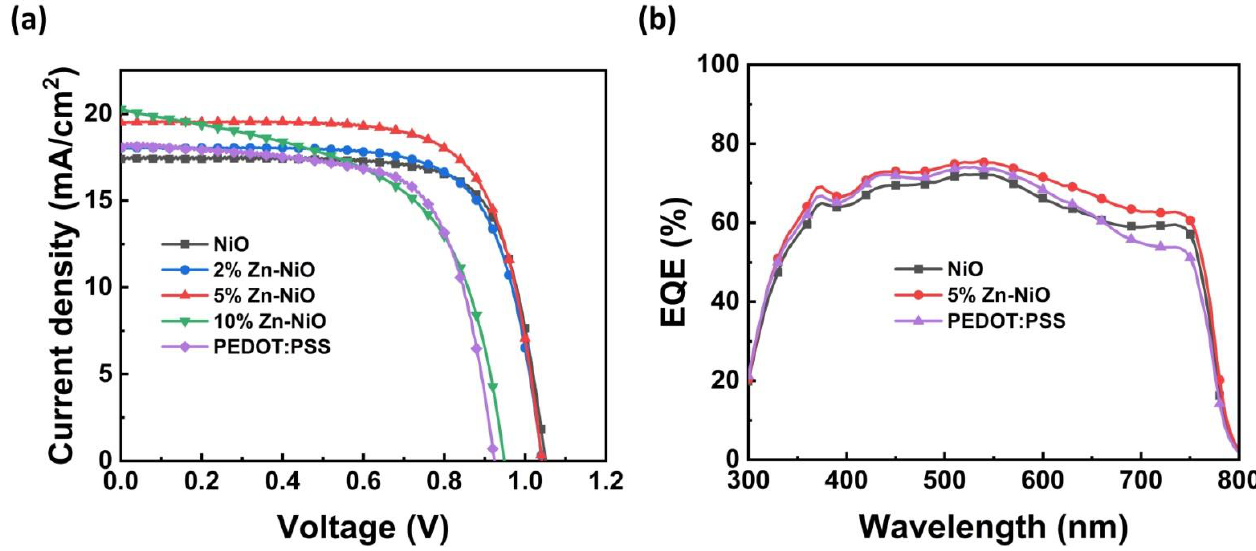
Figure 1. ( a ) Device architecture, ( b ) energy level diagram of inverted PSCs, and ( c ) photograph of the fabricated device.